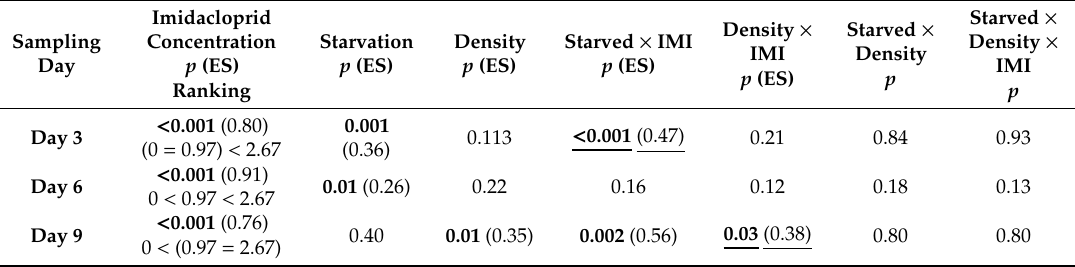
Table 3. Results of three-way ANOVAs comparing the ‘impairment’ response between experimental treatments. p- values < 0.05 are in bold text, and e ff ect sizes (ES; partial η 2 values; range 0–1) are given in brackets where p < 0.10. Two interactions that overrode main e ff ects of starvation or density (due to a larger e ff ect size) are underlined. See Table 2 for further details.